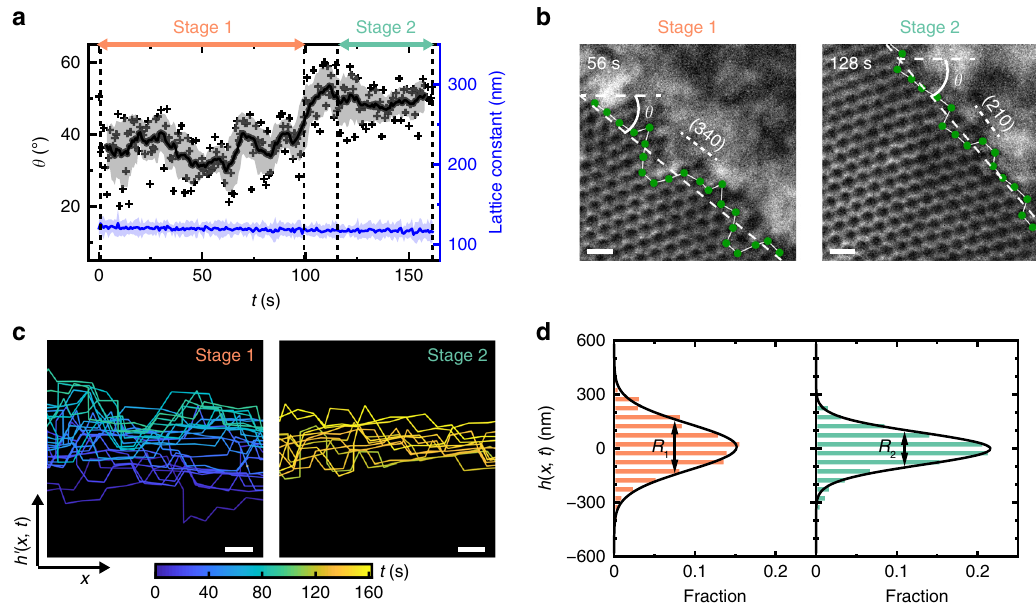
Fig. 3 Shift of surface orientation and facet during the supracrystal growth. a Plot showing the evolution of the surface orientation ( θ , black crosses) over time t as computed from the surface pro fi les. The black fi lled circles are the averaged θ over the successive 8.5 s with the gray shadow denoting s.d. Two stages of θ are observed and highlighted with salmon and aquamarine arrows. The lattice constant σ in the supracrystal (blue line) shows no signi fi cant change during growth with the shadow denoting s.d. b Typical liquid-phase TEM images for stage 1 and stage 2 highlighting the surface orientation shift. The columns at the surface are labeled as green fi lled circles connected by white bonds. White dotted lines denote linear regression of the surface pro fi les. c Surface pro fi les of the supracrystal color coded by elapsed time (4 s interval between neighboring pro fi les). d Corresponding histogram of h ( x , t ), with the black lines denoting the corresponding Gaussian distributions. The surface roughness R 1 for stage 1 and R 2 for stage 2 are labeled as the full width at half- maximum. Scale bars: 200 nm.